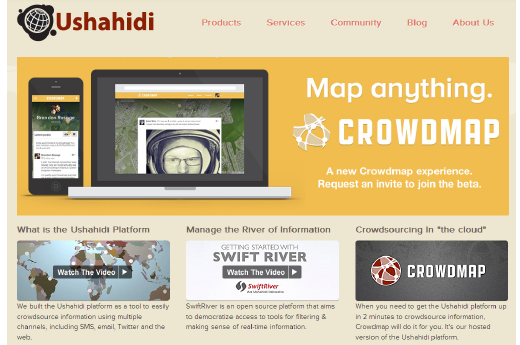
Figure 2: Ushahidi platform (http://ushahidi.com/) Third category: the maps that arise as society's need to address small or large problems of local or global scale (e.g. crisis management), may involve even the entire planet and developed with the help of awareness among citizens. Climate scientists asked the crowd help to classify over 30 years of tropical cyclone satellite imagery. The global intensity record contains uncertainties caused by differences in analysis procedures around the world and through time. Scientists are enlisting the public because patterns in storm imagery are best recognized by the human eye (Figure 3).